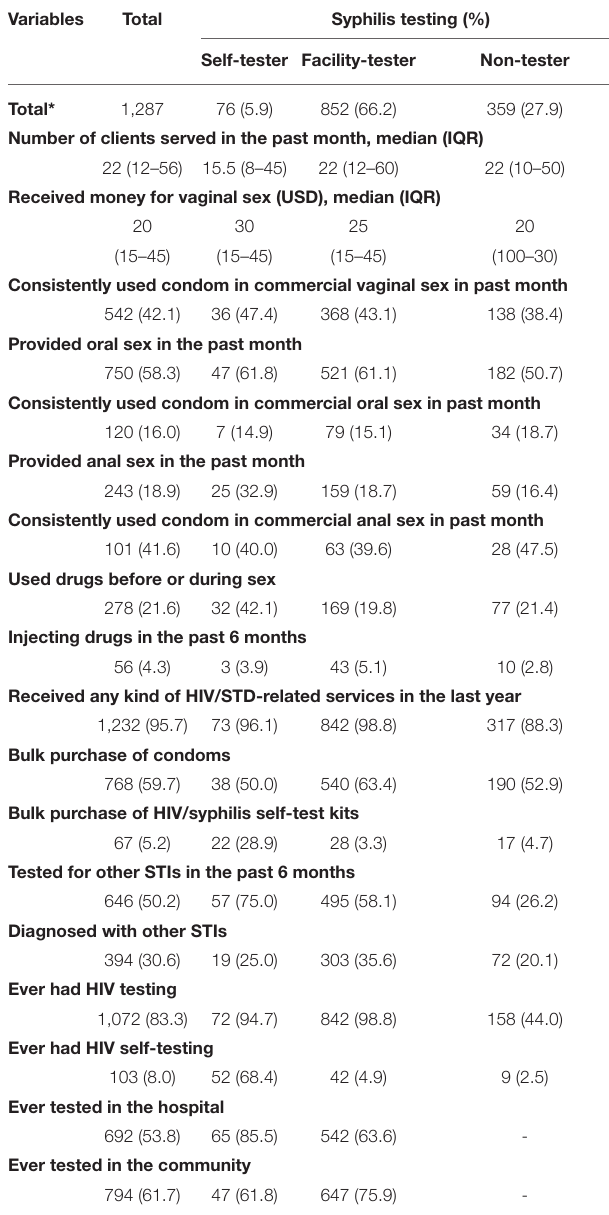
TABLE 3 | Past syphilis self-test experience, post-test health services utilization, and potential harms of syphilis self-testing among Chinese female sex